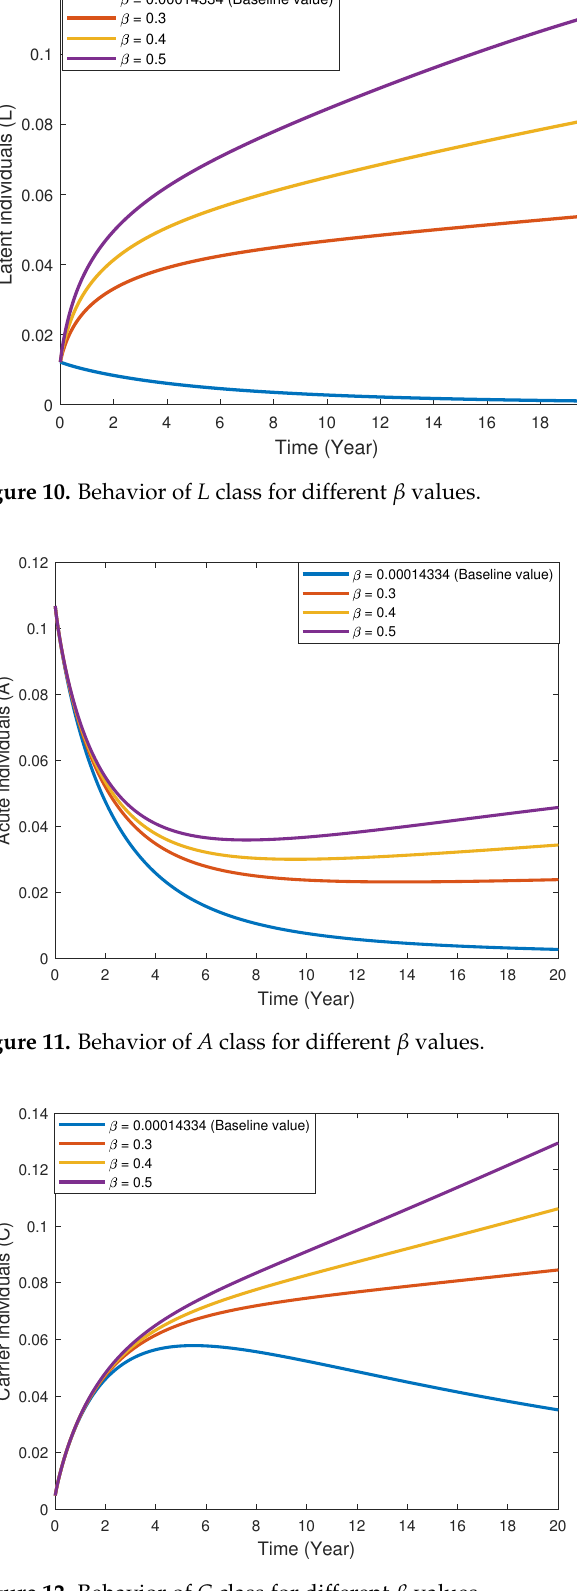
Figure 12. Behavior of C class for different β